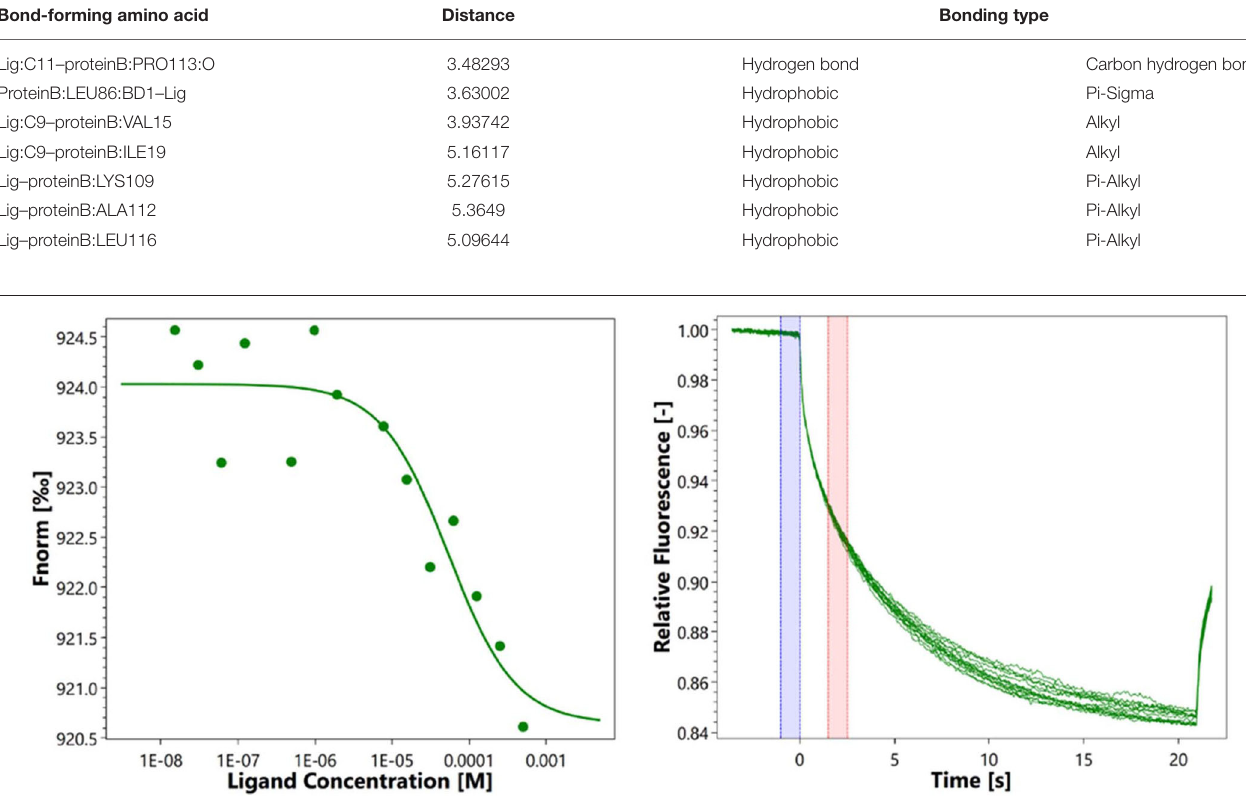
FIGURE 5 | Microscale thermophoresis measurements of eugenol to